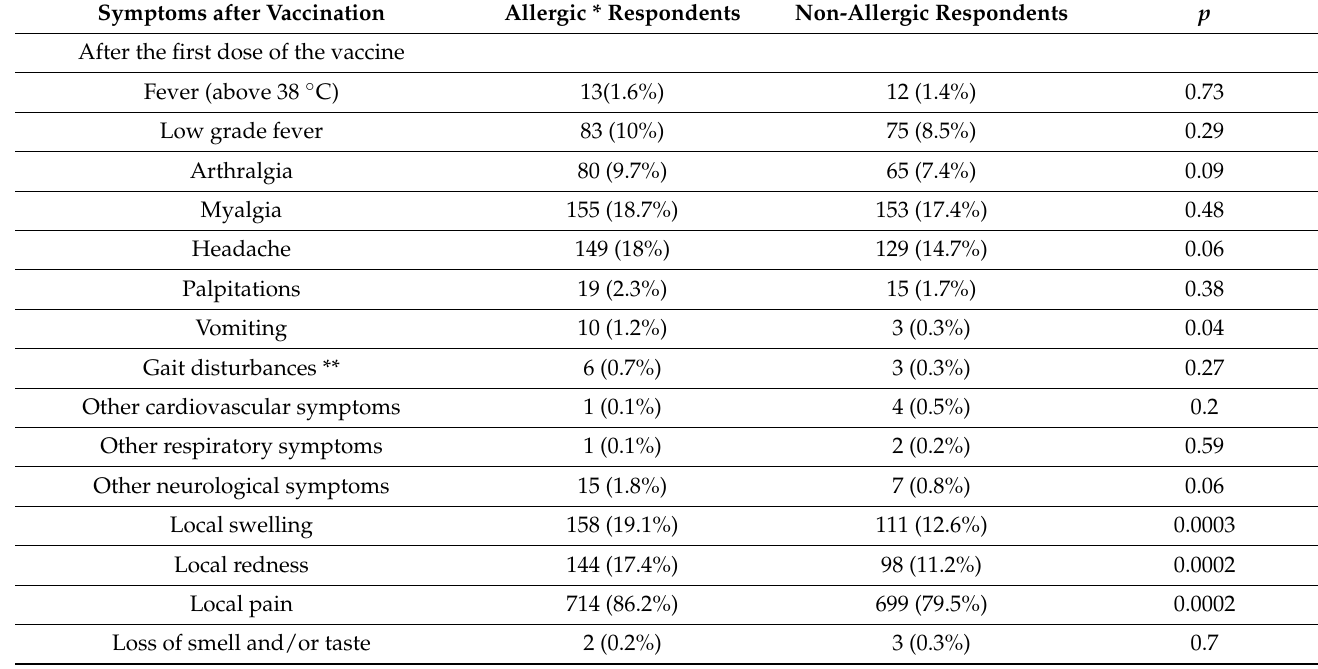
Table 2. Characteristics of reported adverse symptoms after receipt of the first and the second dose of Comirnaty vaccine in the study group ( n =